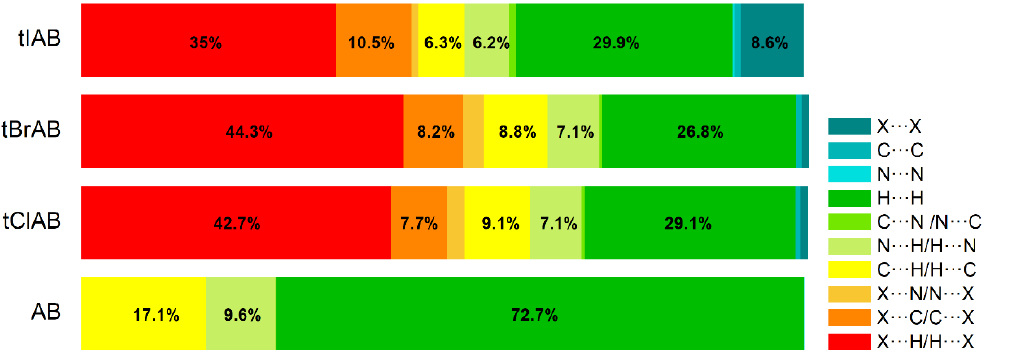
Figure 5. Percentage contributions to the 3D Hirshfeld surface area from the various intermolecular contacts in the set of compounds studied.